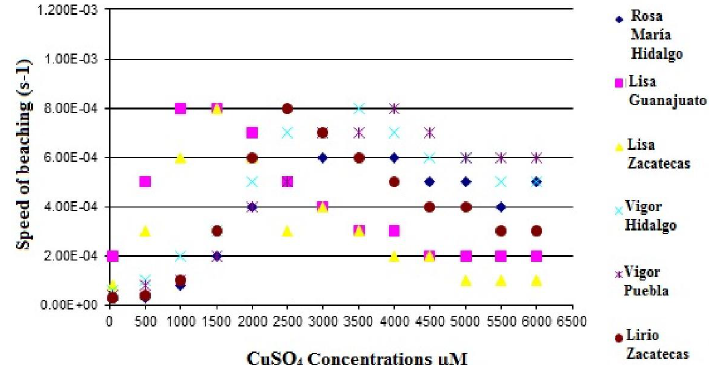
Figure 10. Speed of bleaching of betacyanin in the read cactus pear cultivars as a function of the CuSO 4